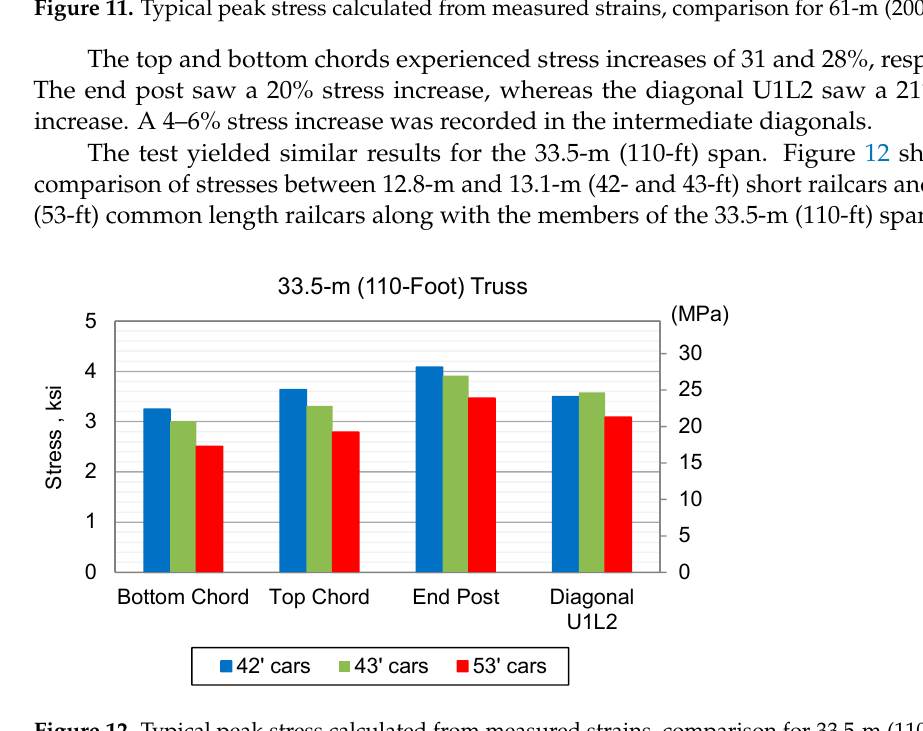
Figure 12. Typical peak stress calculated from measured strains, comparison for 33.5 ‐ m (110 ‐ ft) span. The top and bottom chords each experienced a 30% increase in stresses due to the short railcars. The end post saw an 18% increase, and the diagonal U1L2 saw a 13% stress increase due to short